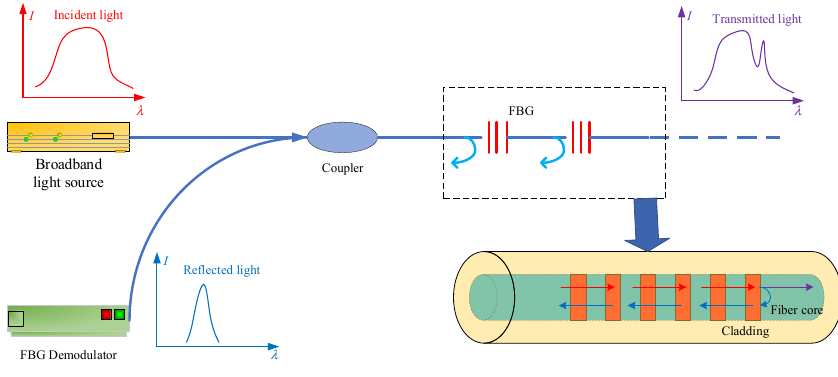
Figure 4. FBG sensing schematic.